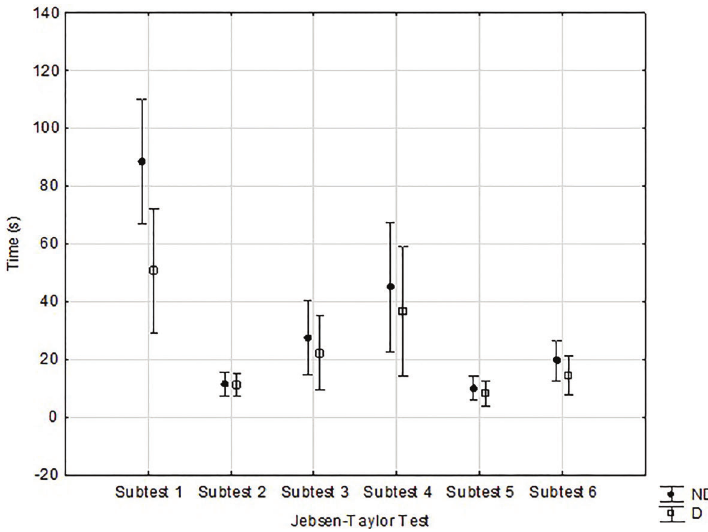
Figure 1. Repeated measures analysis of var- iance reported as means and 95% con fi dence intervals for each subtest of Jebsen-Taylor Test, comparing non-dominant (ND) and dominant (D) upper limbs. There was an interaction between subtest and limb (P o 0.001) and post hoc Tukey